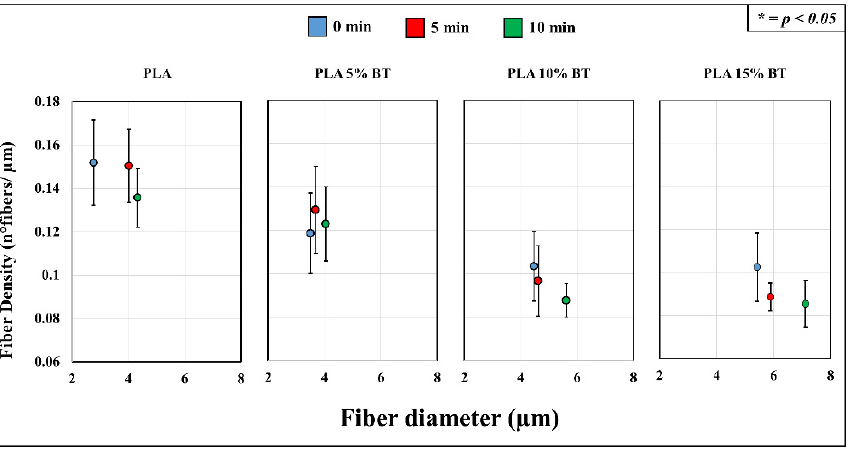
Figure 7. Fiber density and diameter of the PLA matrix and composites calculated using five im- ages for each class of substrates collected by SEM at 500 × magnification.